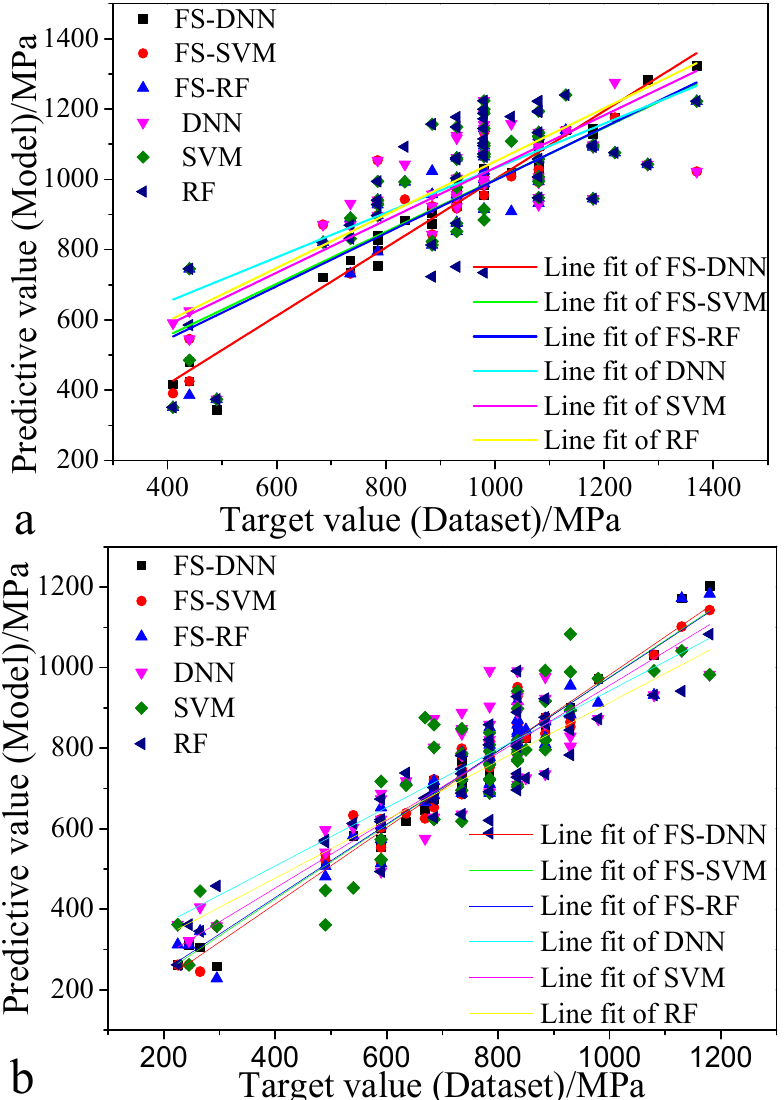
Figure 8. Actual values of the mechanical properties and the predicted values fit to a straight line: ( a ) tensile strength and ( b ) yield strength.